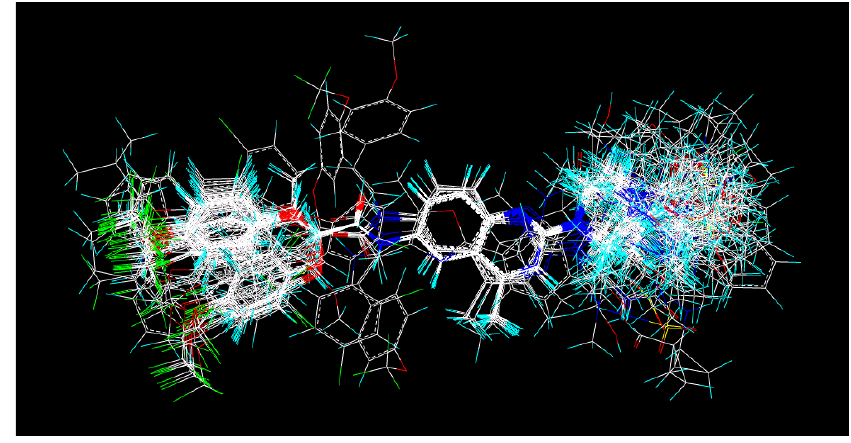
Figure 12. Ligand-based alignment of all